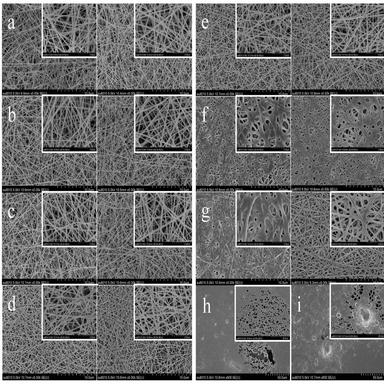
SEM images of PPI/PUL NFs with various glucose content before (left) and after (right) cross-linking: a-0%, b-0.5%, c-1.0%, d-1.5%, e-2.0%, f-2.5%, g-3.0%, h-3.5% and i-4.0% (The magnifications in SEM pictures are 5000 × and 20,000 ×).